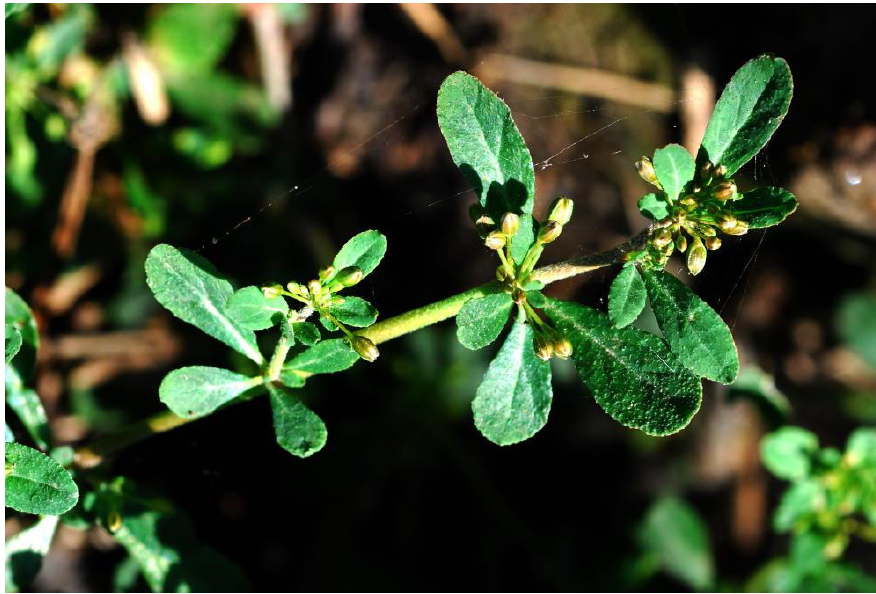
Figure 1. Plant material: Glinus oppositifolius (L.) Aug. DC.